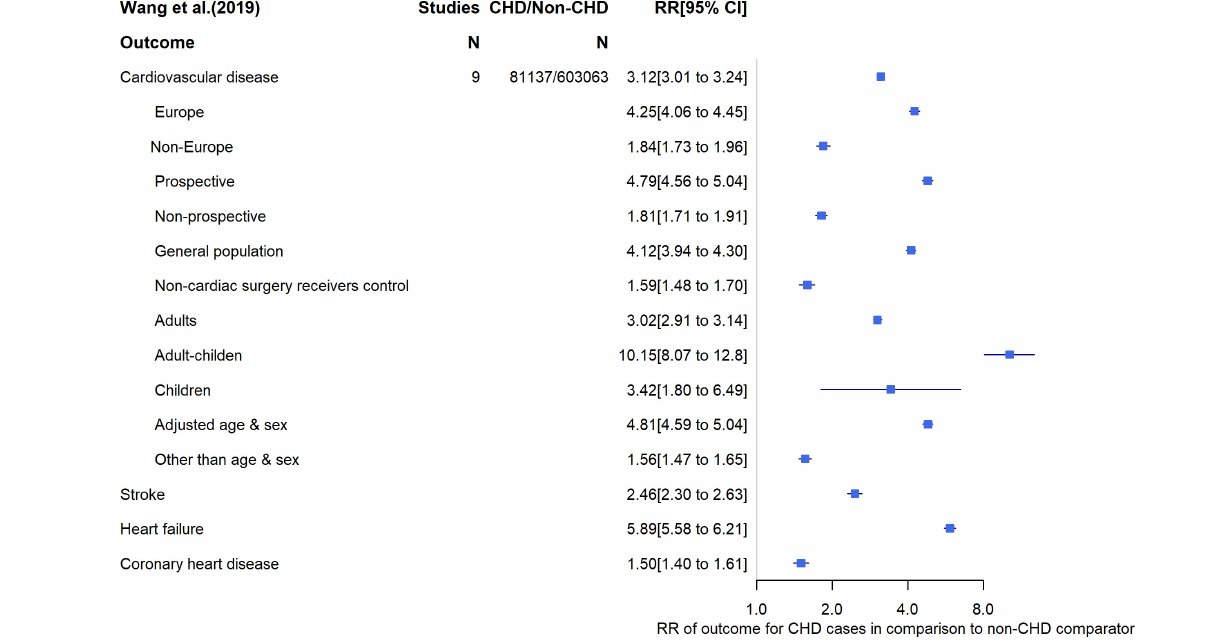
FIGURE 2 | Relative risk for cardiovascular outcome and subgroup